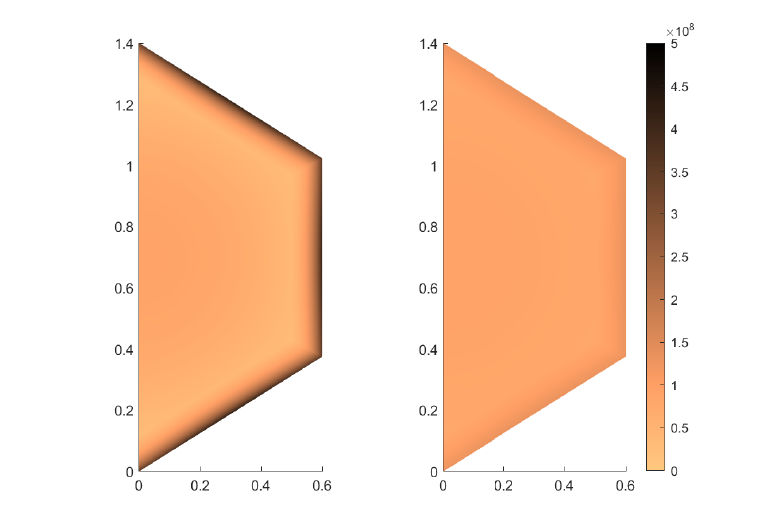
Figure 8. Concentration of platelets at the final time for the case of p m = 0.5 (left) and p m = 0.1